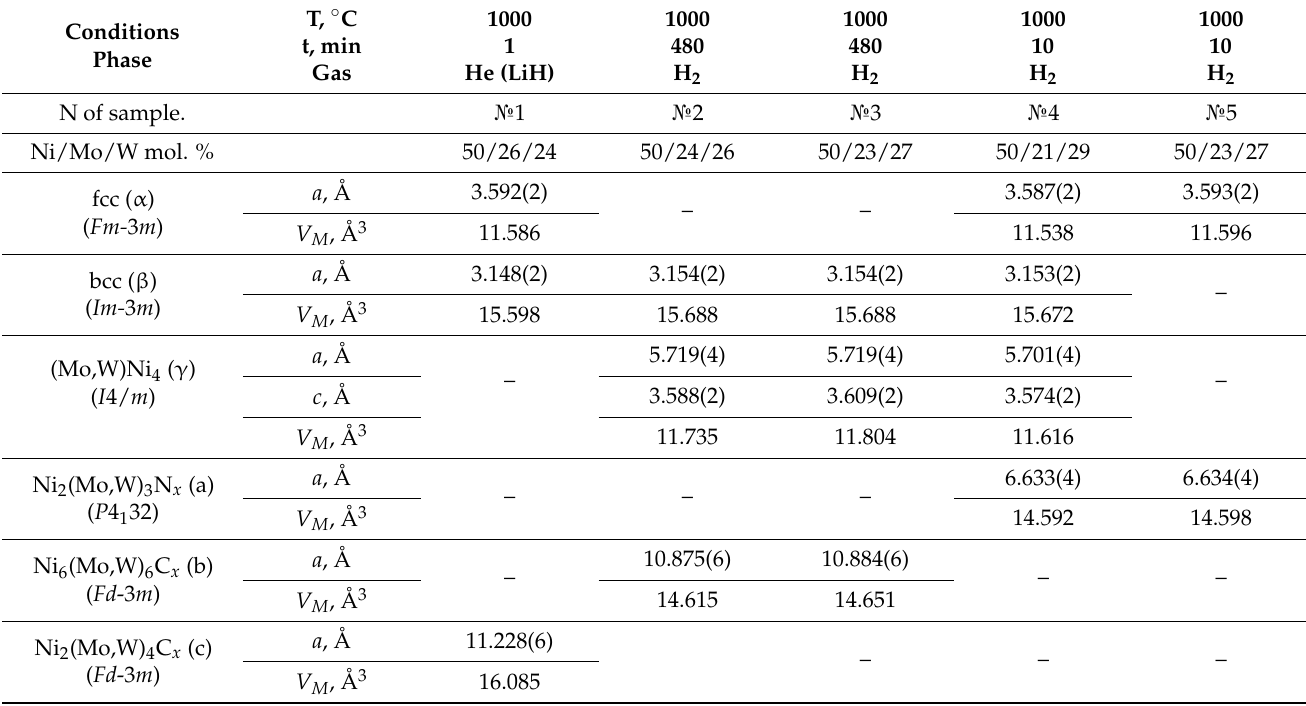
Table 2. The results of the X-ray phase analysis of thermal decomposition products (the crystal numbers correspond to the numbers from Table